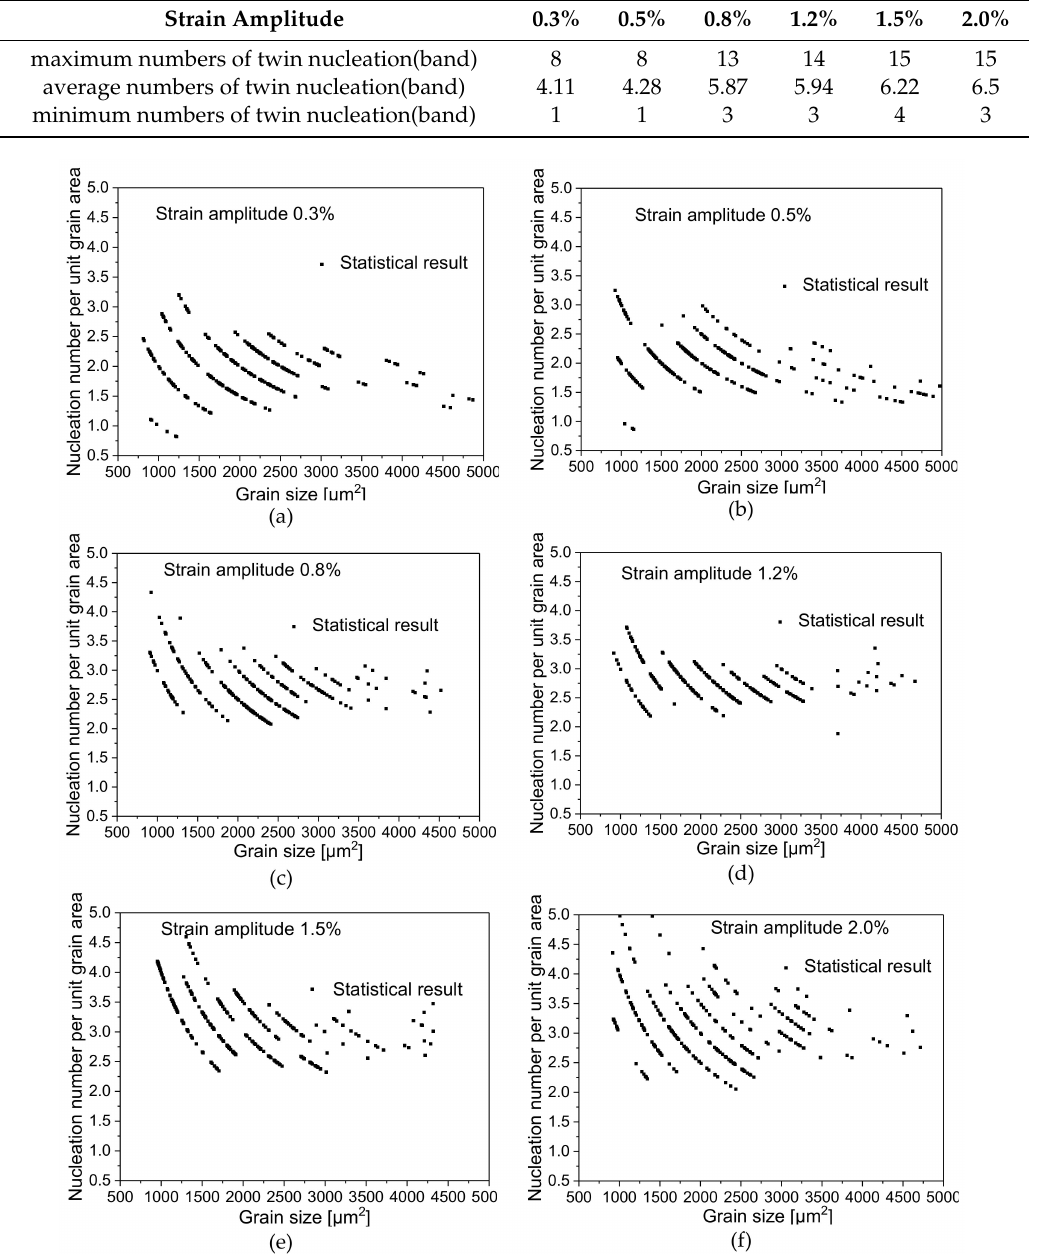
Table 4. Distribution of the relationship between strain amplitudes and average twin nucleation number (TNN).